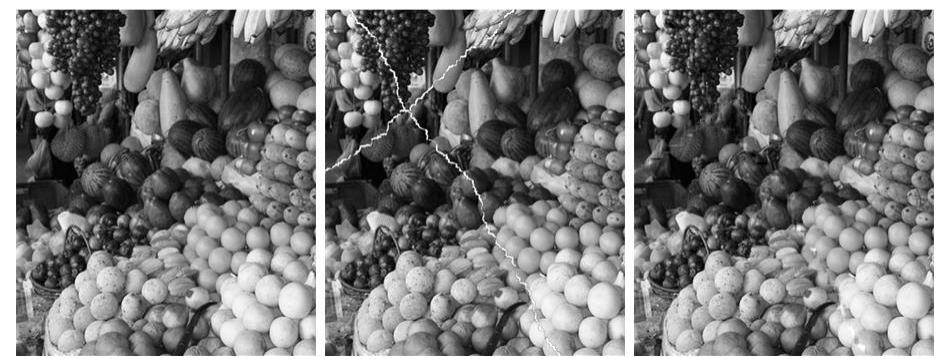
Fig. 3. The third test photo (fruits): the undamaged, the ripped, and the recovered versions were arranged from left to right in series.